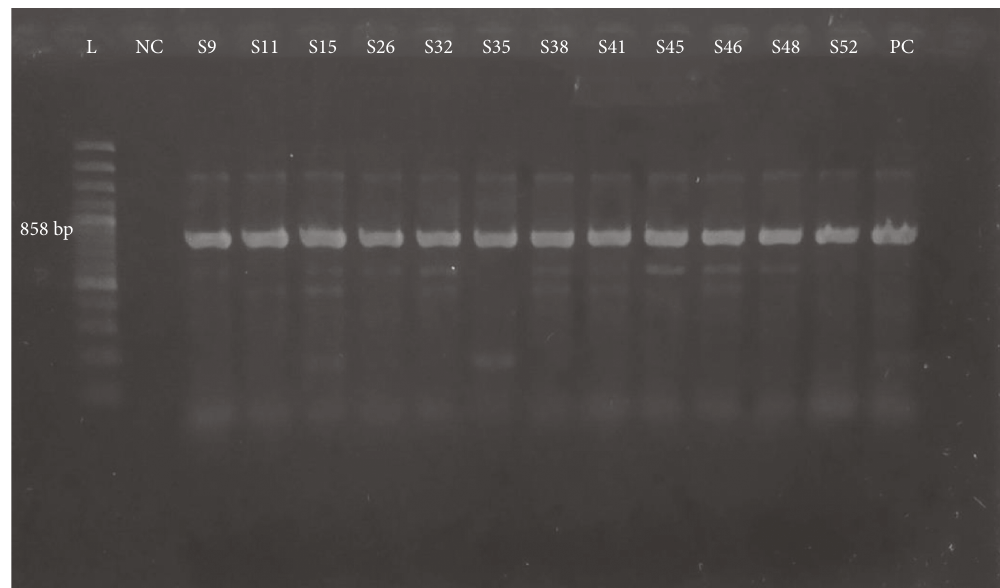
Figure 3: Representative gel image showing amplification of bla SHV-11 gene (858 bp): Lane L Ladder (100bp); Lane NC: negative control; Lane PC: positive control; SHV-11 positive Kpn isolates; Lane S9– S52: clinical